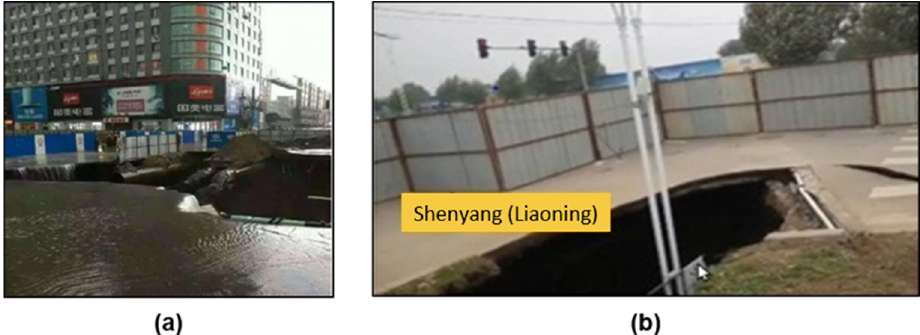
Figure 14. Images of reported collapse events along subway lines: ( a ) collapse at the intersection of line 1 and line 9; ( b ) collapse at Caozhong station (marked by red triangle in Figure 13a), line 9.